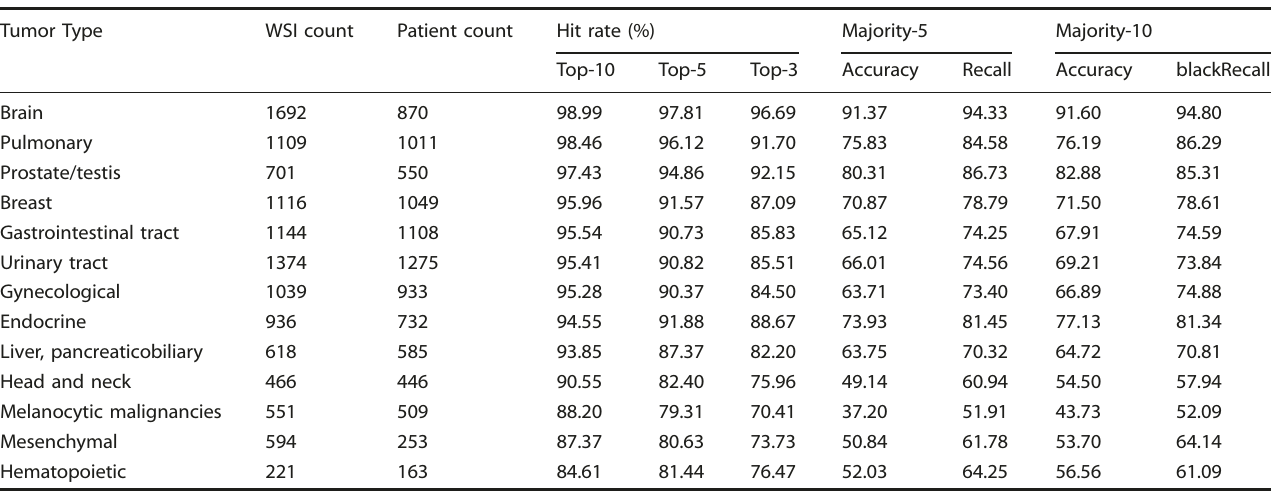
Table 2. Results for cancer-type recognition (horizontal search) among diagnostic